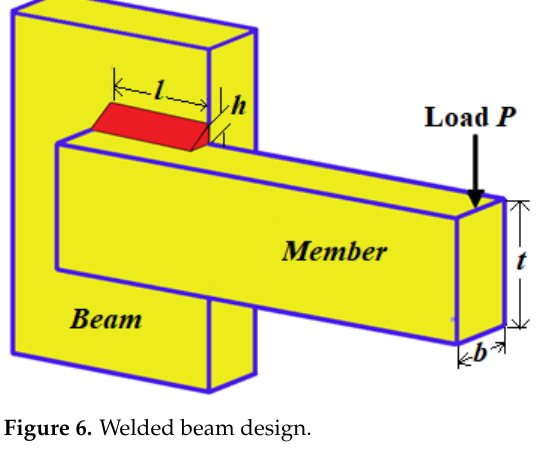
Figure 6. Welded beam design. Table 12. Optimal design of welded